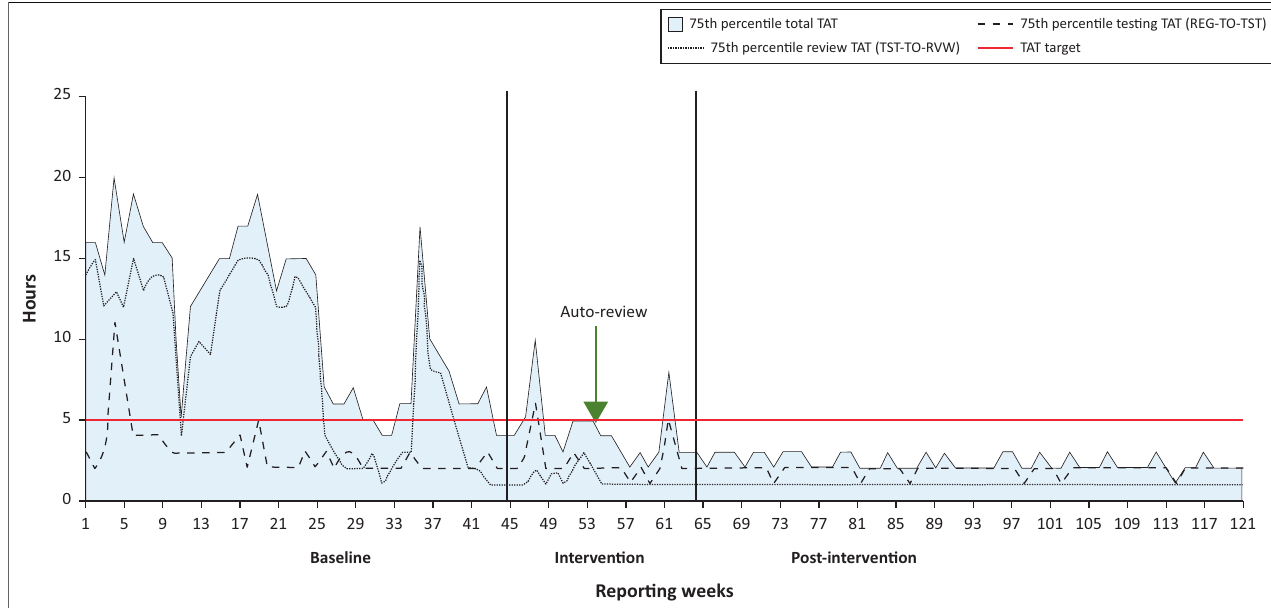
FIGURE 2: 75th percentile total turn-around time for creatinine testing at a high-volume laboratory across 122 weeks after implementation of an interactive weekly dashboard, Gauteng, South Africa, 2017.